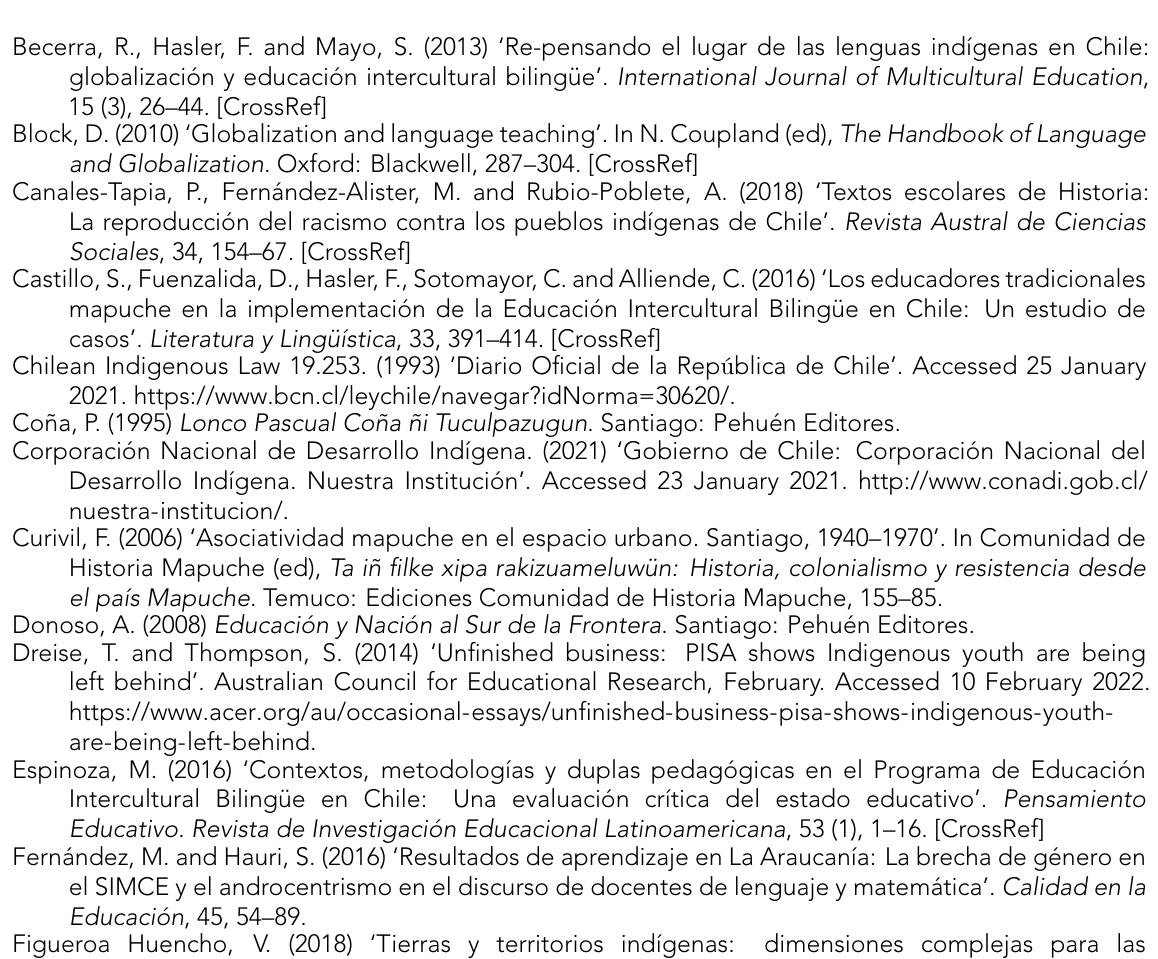
Figueroa Huencho, V. (2018) ‘Tierras y territorios indígenas: dimensiones complejas para